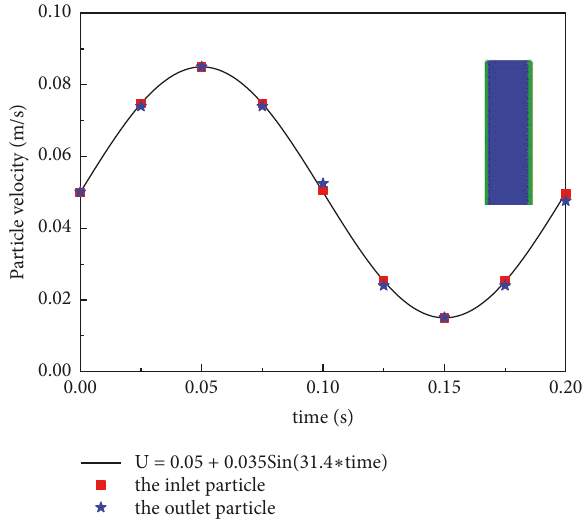
Figure 5: The velocity of inlet and outlet particles under flow pulsation